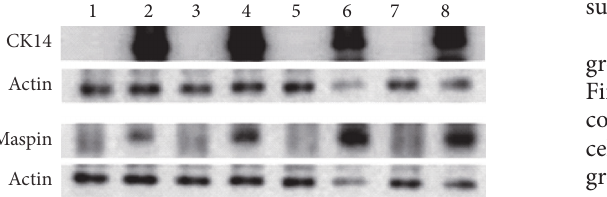
in the K-NAC medium with cholera toxin (14